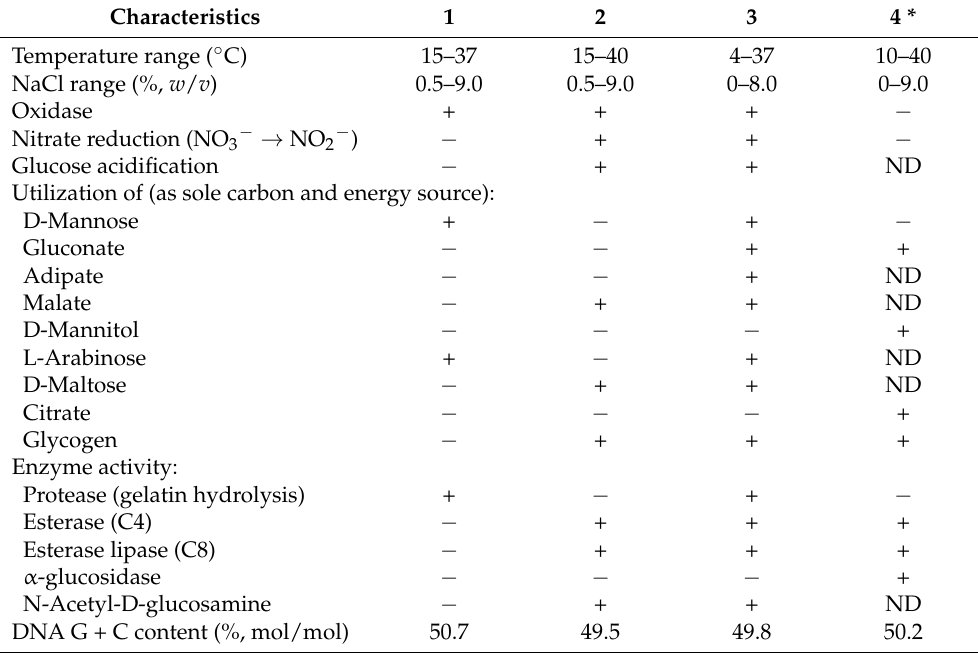
Table 1. DifferentialphysiologicalcharacteristicsofstrainGJ3 T andreferencestrainsofthegenus Photobacterium .